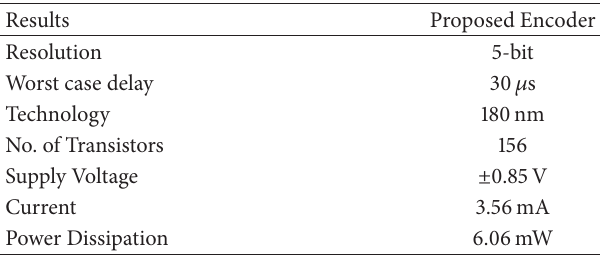
Table 3: Summary of proposed encoder. Table 4: Transistor count of the designed system